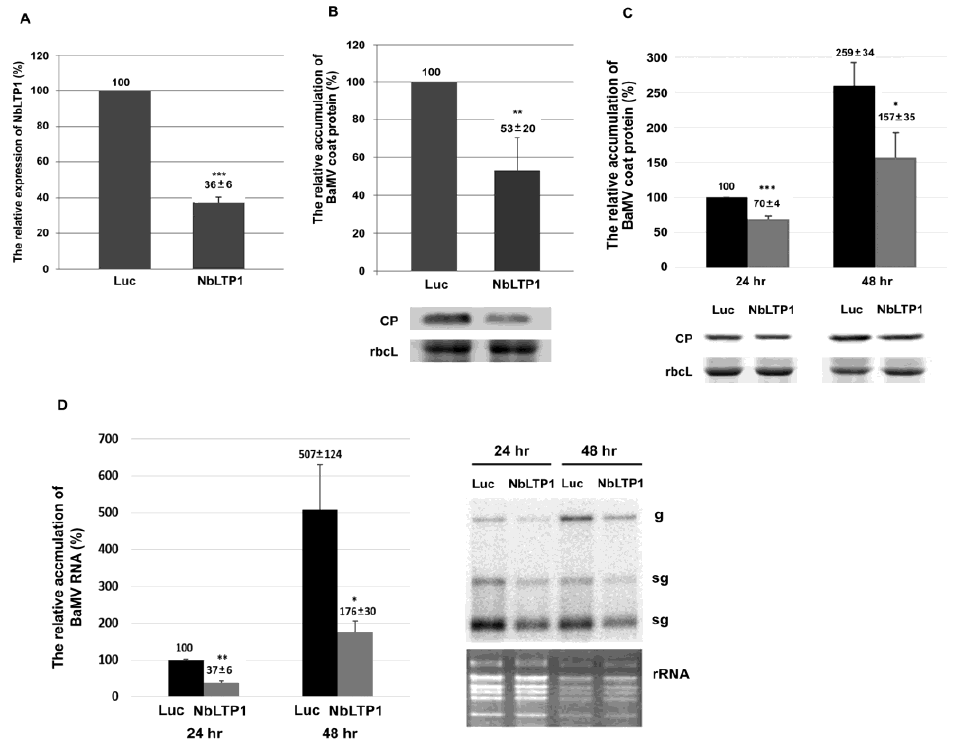
Figure 2. Relative accumulation of Bamboo mosaic virus (BaMV) coat protein (CP) in NbLTP1 -knockdown leaves and protoplasts. ( A ) Real-time qRT-PCR of NbLTP1 level in NbLTP1 -knockdown and negative control (Luc) plants. ( B ) Western blot analysis of viral BaMV CP accumulation. The accumulation of BaMV CP ( C ) and RNA ( D ) was determined by Western and Northern blot analyses, respectively. The accumulation in negative control (Luc) protoplasts at 24 h postinoculation (hpi) was set to 100%. The level of rbcL was used for normalization. The accumulation in negative control plants was set to 100%. Luc: negative control; NbLTP1: NbLTP1 -knockdown; rbcL: Rubisco large subunit (the loading control). Data are mean ± SE from at least three independent experiments. * p < 0.05; ** p < 0.01; *** p < 0.001 by a Student’s t